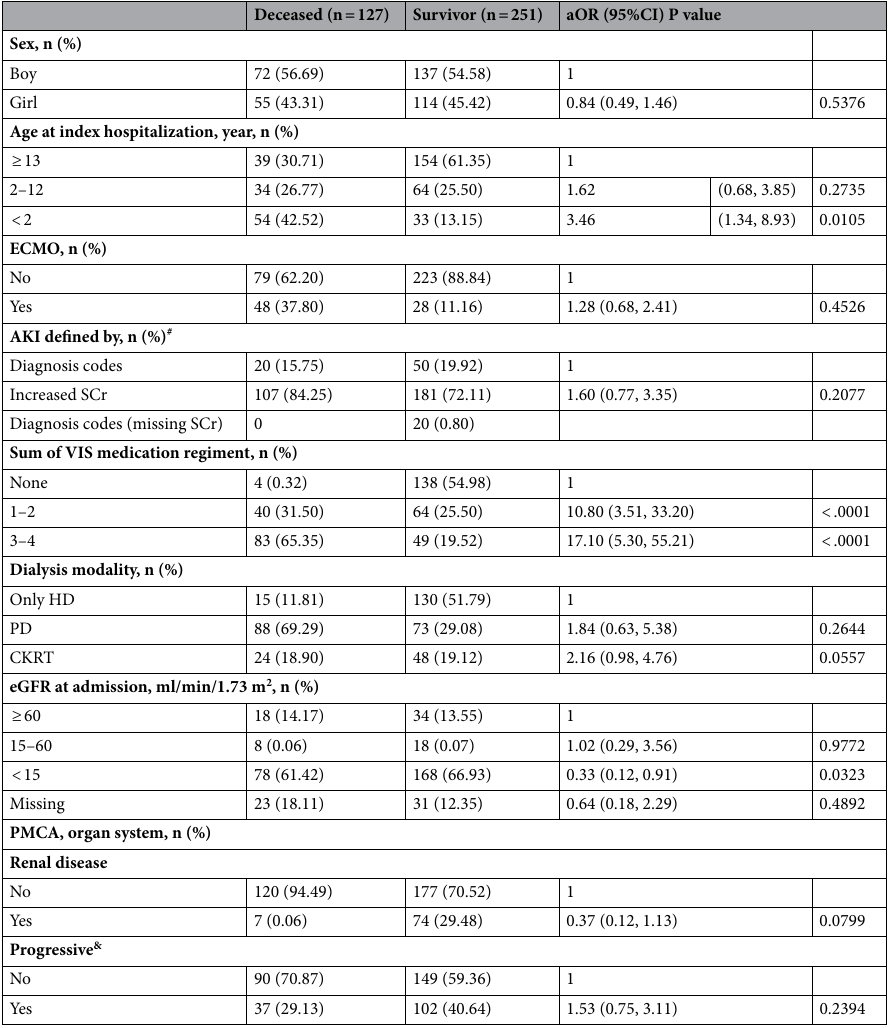
level, VIS vasoactive inotropic score (dopamine dose (mcg/kg/min) + dobutamine dose (mcg/kg/ min) + 100 × epinephrine dose (mcg/kg/min) + 10 × milrinone dose (mcg/kg/min) + 10,000 × vasopressin